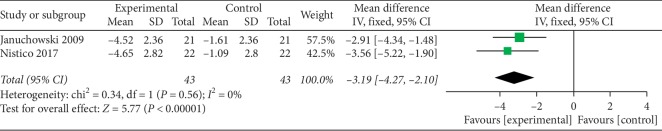
Forest plot of the meta-analysis of vitamin B12 and atopic dermatitis.